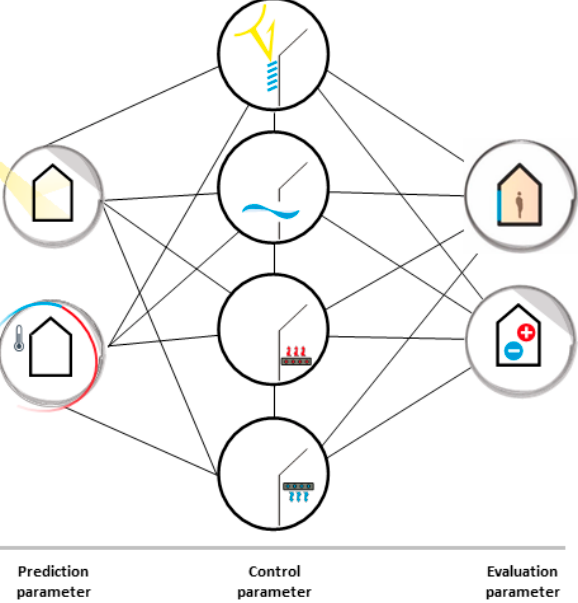
Figure 5. Graphical illustration of the concept and its individual prediction, control, and evaluation parameters (own representation).